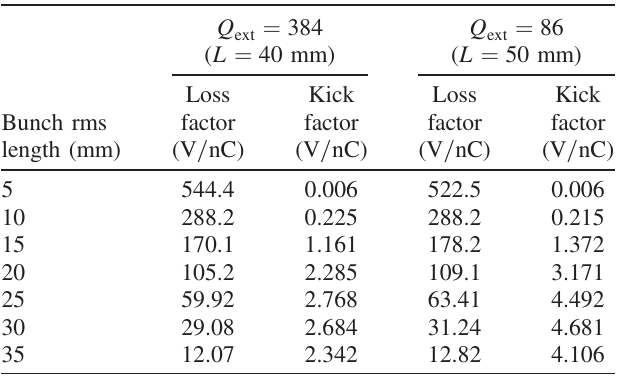
TABLE II. Calculated loss factor and damping kick factor with different Gaussian-bunch rms lengths. Two coupling strengths ¼ 86 and Q ¼ 384 are investigated with CST Particle Q ext ext